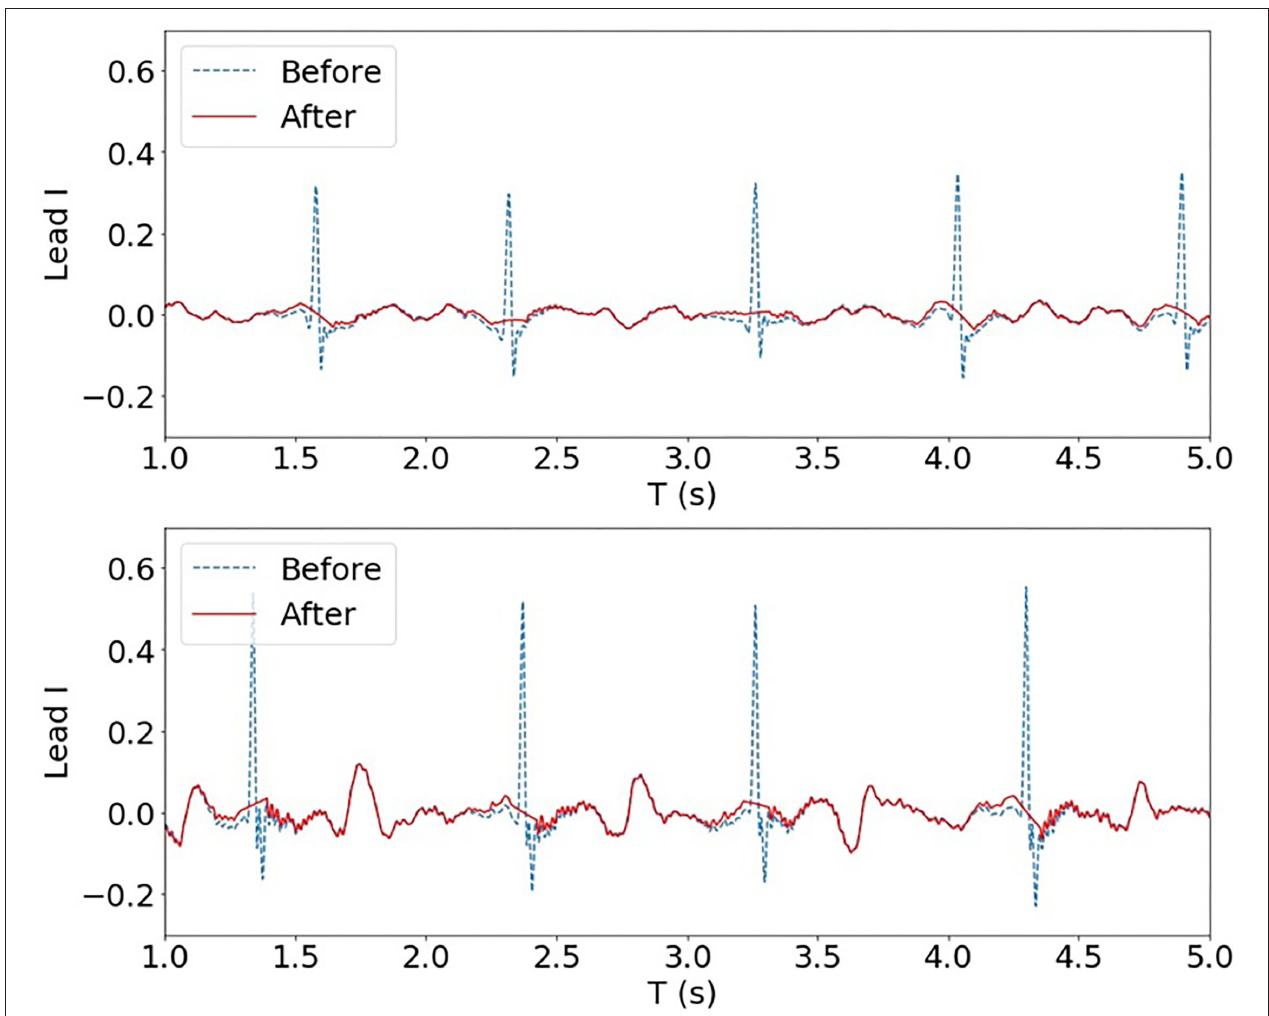
FIGURE 2 | Two examples of QRS subtraction applied to the AF ECG data set (Lead I). Upon QRS detection, points corresponding to a QRS duration of 0.10 s were replaced with linearly interpolated